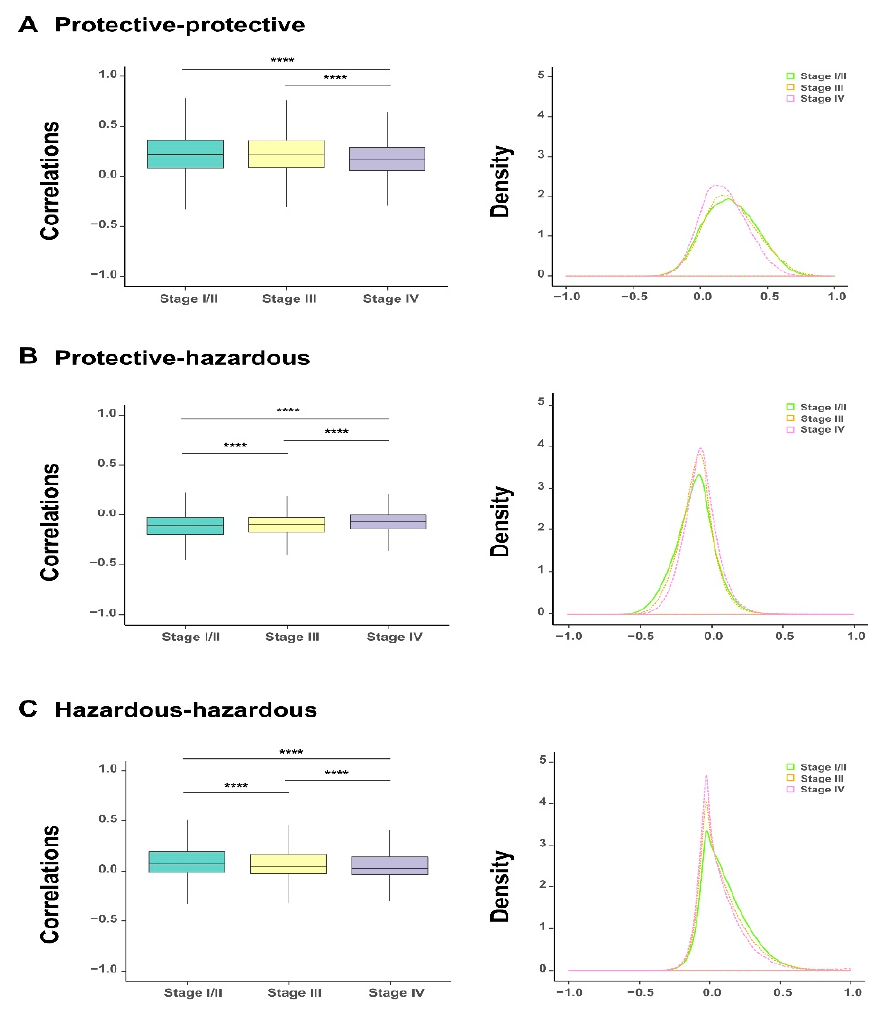
Figure 3. The dynamic changes of correlations between the selected 1078 survival-related genes for bladder urothelial carcinoma (BLCA) patients at different cancer stages. The boxplots on the comparisons of correlation coefficients (all outliers are not shown) and the corresponding density curves between protective and protective genes, protective and hazardous genes, and hazardous and hazardous genes, respectively ( A – C ). * p -value < 0.05; ** p- value < 0.01; *** p -value < 0.001; **** p- value < 0.0001; two-sided Wilcoxon rank–sum test.